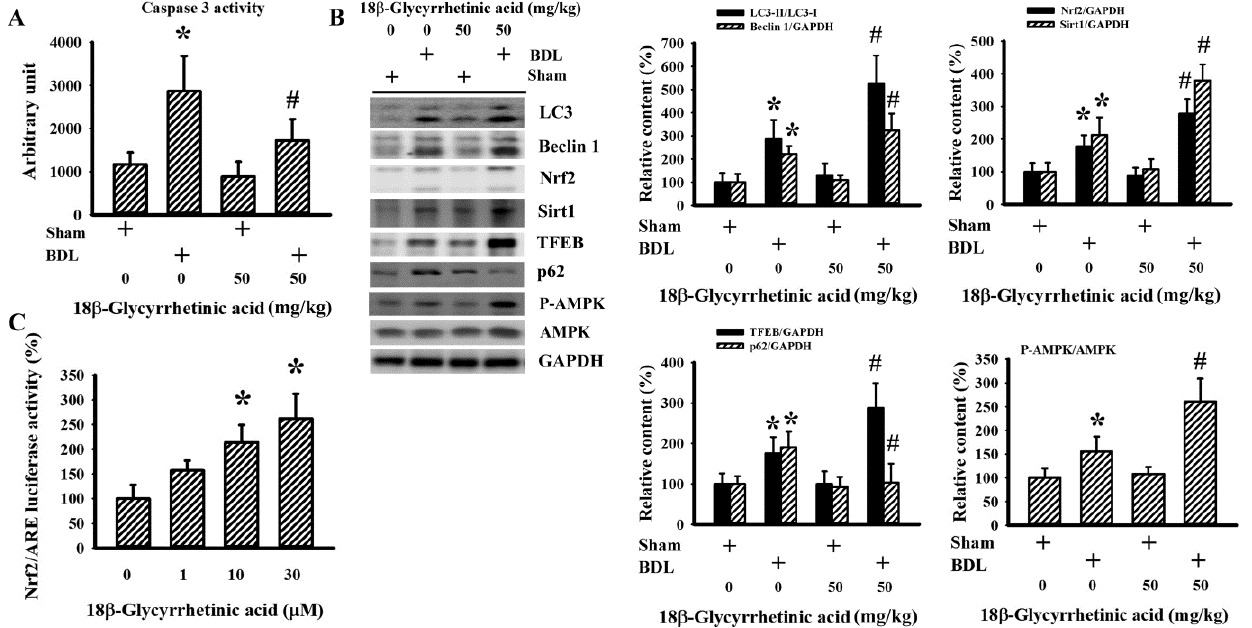
Figure 10. 18 β -Glycyrrhetinic acid improved BDL-altered hepatic signaling molecules in the treatment study. ( A ) Liver tissues were collected and subjected to the measurement of caspase 3 activity. ( B ) Protein contents in liver tissues were measured using Western blot with indicated antibodies. Representative blots and the quantitative data are shown. * p < 0.05 vs. the sham vehicle group and # p < 0.05 vs. the BDL vehicle group, n = 8. ( C ) NRF2/ARE luciferase reporter stable HepG2 cells were treated with various concentrations of 18 β -Glycyrrhetinic acid for 24 h. Cells were harvested, lysed, and subjected to the measurement of luciferase activity. * p < 0.05 vs. un-